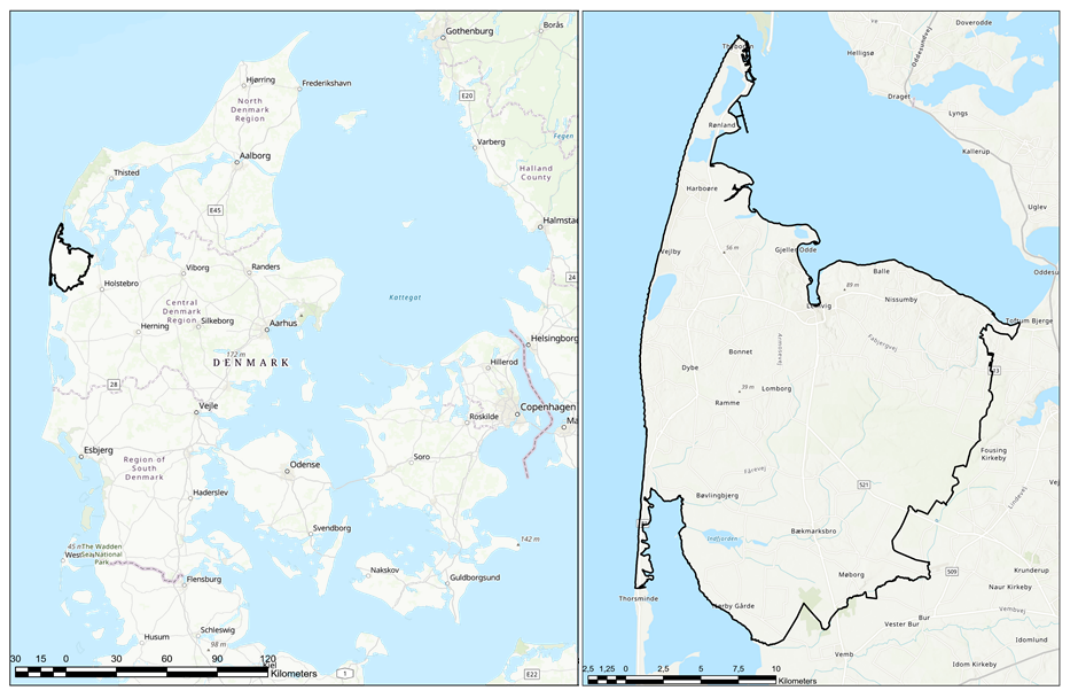
Figure 1. Location of the Municipality of Lemvig, Denmark. Source: The Danish Agency for Data Supply and Efficiency